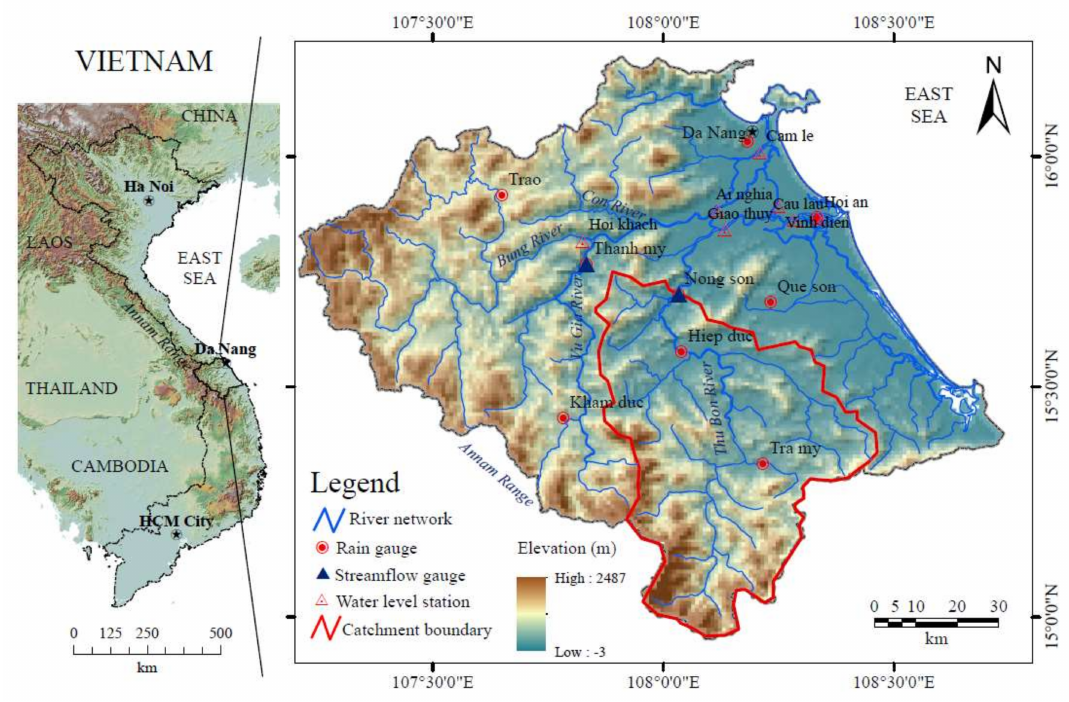
Figure 2. Map of the upper Thu Bon River basin as delineated at Nong Son stream gauge and locations of hydro-meteorological observation, modified after